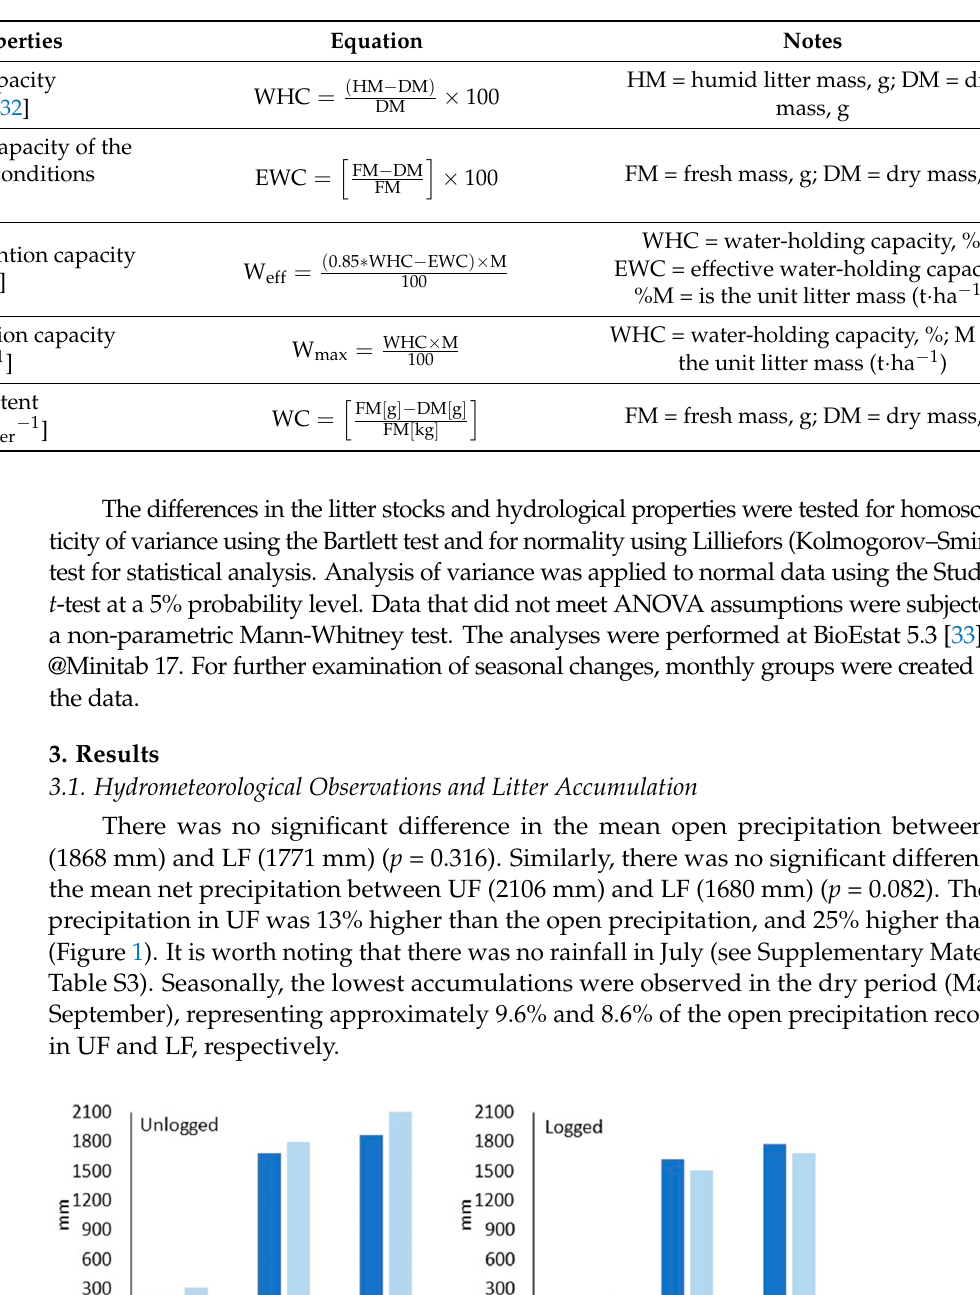
Table 2. Hydrological properties of litter applied to unlogged and logged litter from Amazon Forest, Rond ô nia, Brazil.